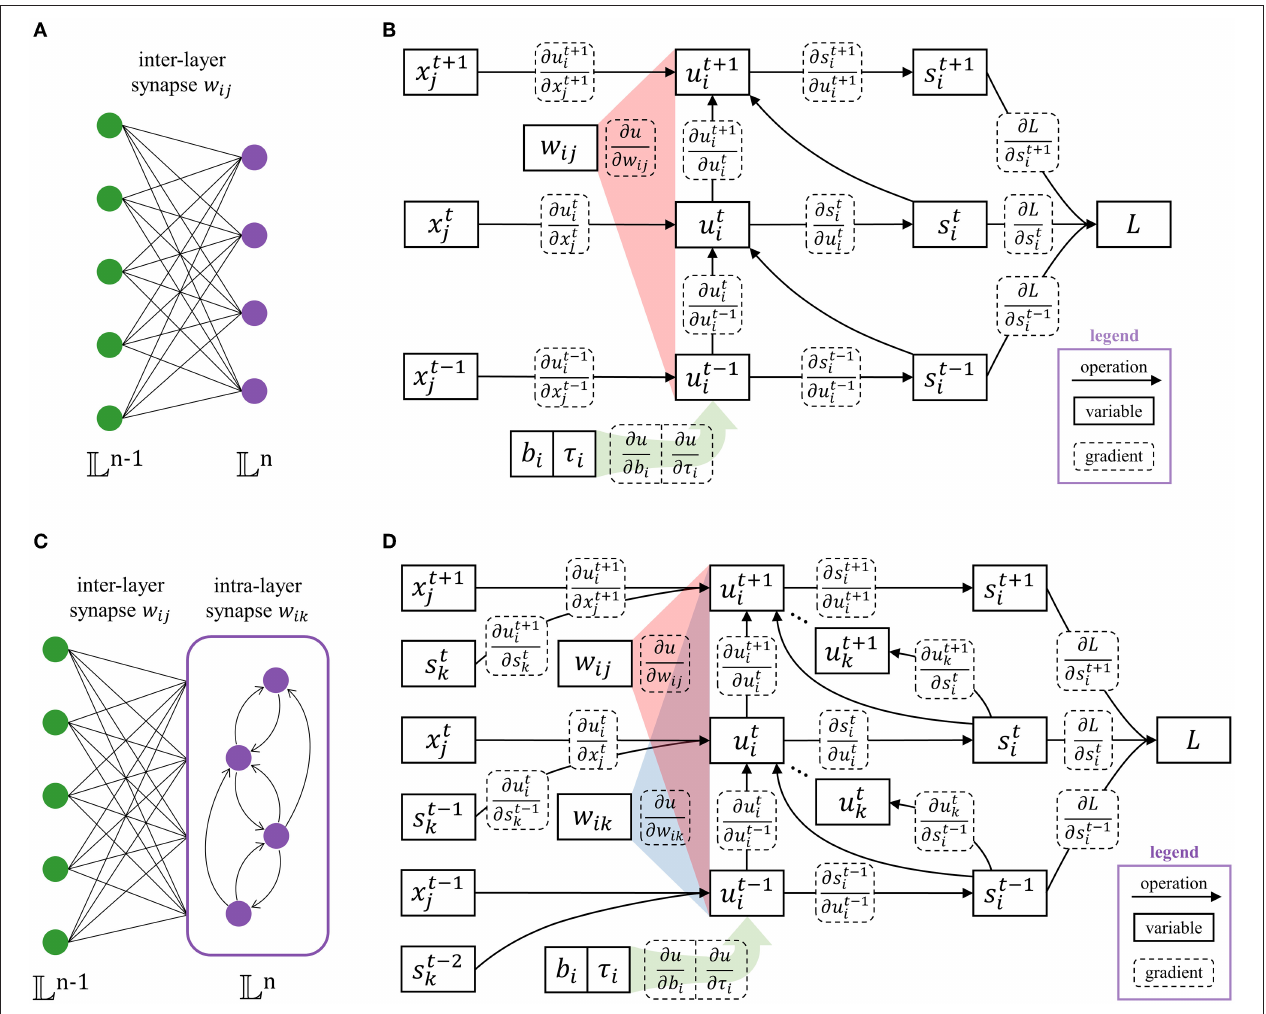
0), and (C) the recurrent layer with intra-layer synapses =